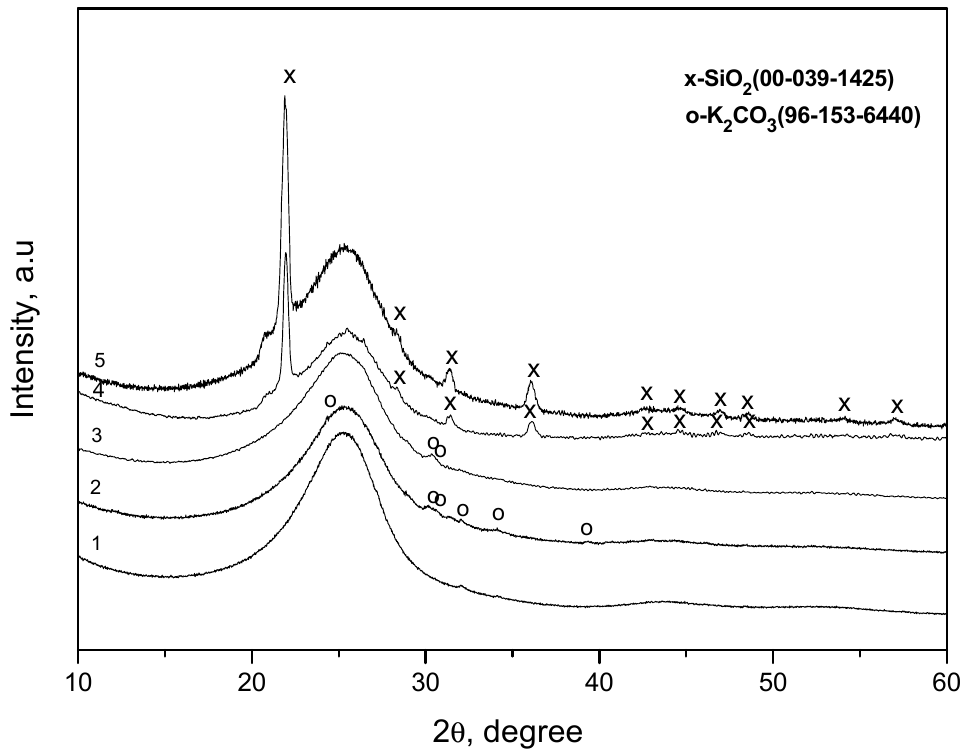
Figure 1. X-ray diffraction patterns of the carbon fiber surface: ( 1 ) uncoated; ( 2 ) coated before heat treatment and after heat treatment at: ( 3 ) 570, ( 4 ) 870, and ( 5 ) 1170 °C.